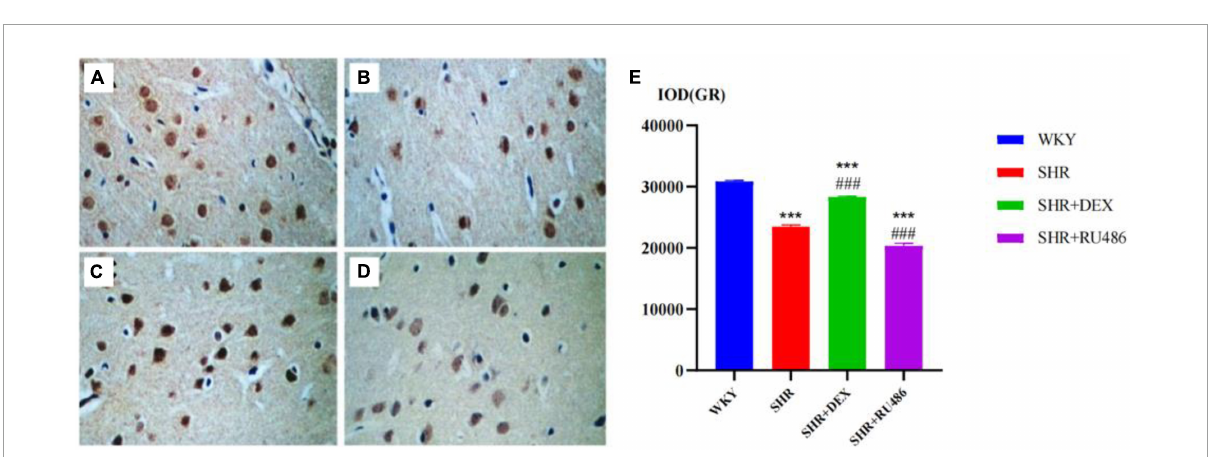
FIGURE5 The immunohistochemical images for the measurements of glucocorticoid receptor (GR) levels in the prefrontal cortex of rats in four groups ( × 400) [ (A) Wista Kyoto rats (WKY) group; (B) spontaneously hypertensive rats (SHR) group; (C) SHR + dexamethasone (DEX) group; (D) SHR + RU486 group); Comparison of GR levels in the prefrontal cortex of rats in four groups (E) . One-way analysis of variance (ANOVA) with repeated measures followed by post hoc with Tukey test. All data are presented as mean ± SEM. *** p < 0.001, compared to WKY group; ### p < 0.001, compared to SHR